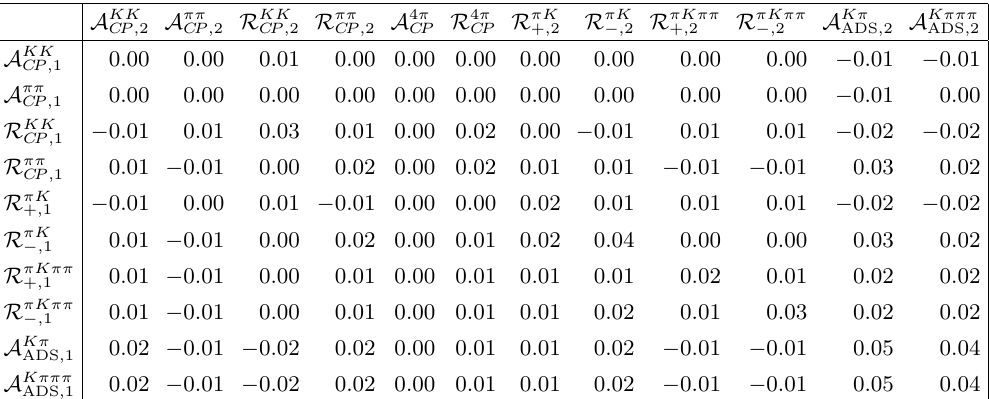
Table 7 . Correlation matrix for the principal observables between Run 1 and Run 2